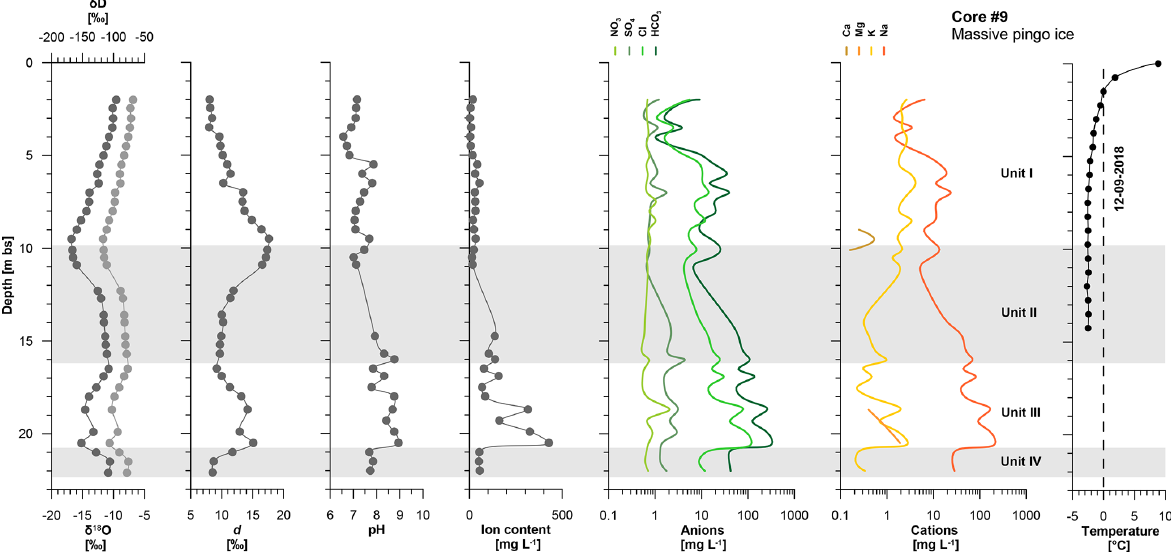
Figure 2. Isotopic and hydrochemical composition of the massive ice of Fili pingo obtained from core 9 as well as thermometric data from the borehole on 12 September 2018. Light grey symbols in the first plot refer to the upper x axis ( δ D). Data are given in Tables 1 and